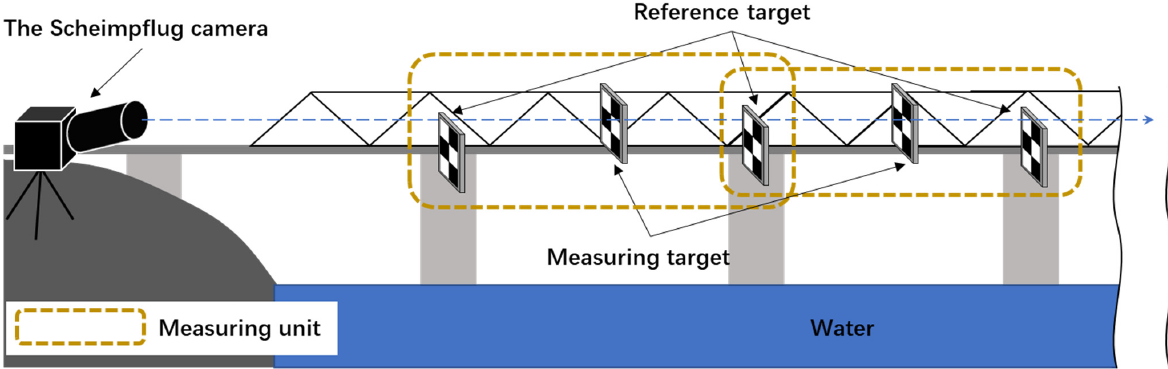
Figure 3. Scheimpflug camera-based system.